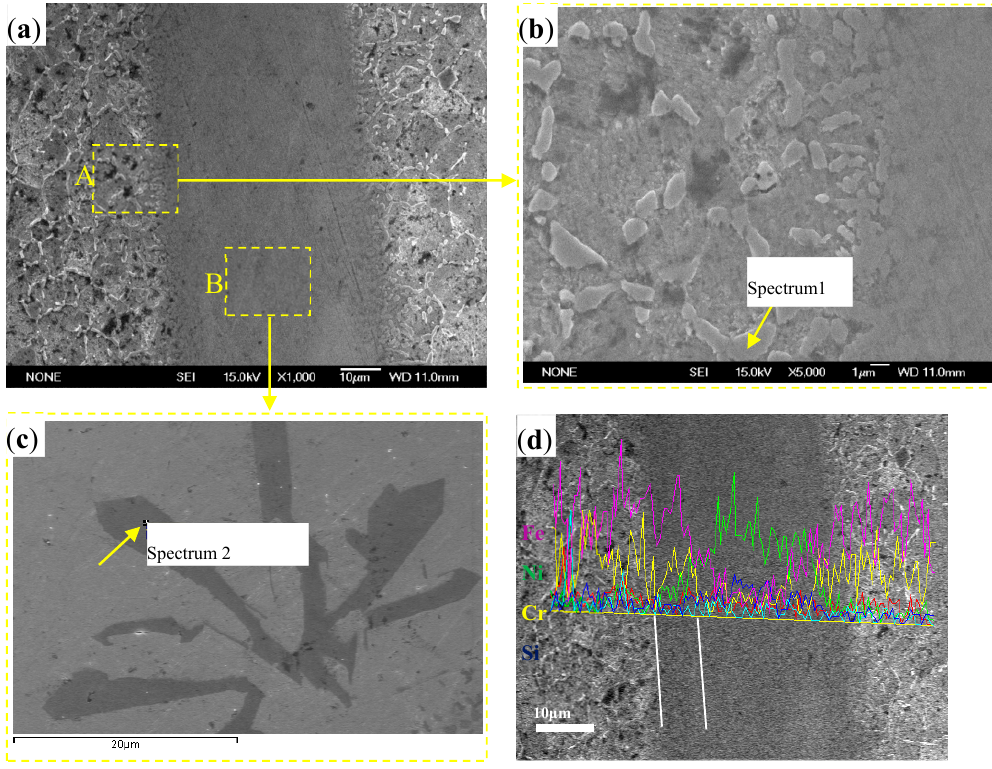
Figure 1. Microstructure of ( a ) brazed joint; ( b ) magnified morphology of zone “A”; ( c ) magnified morphology of zone “B” and ( d ) line scanning analysis.